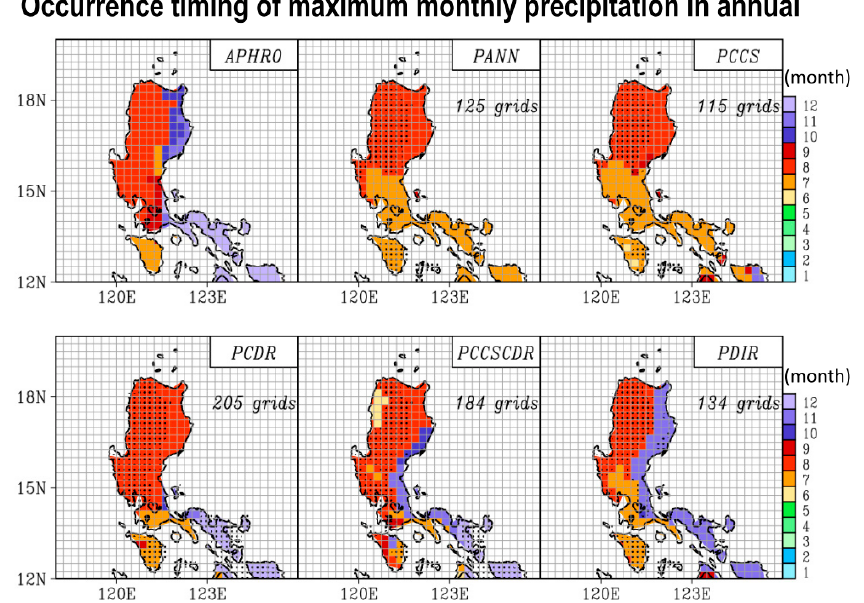
Figure 3. Phase diagram for depicting the timing of the occurrence of maximum value of monthly precipitation constructed based on APHRO and the five products of the PERSIANN-series (including PANN, PCCS, PCDR, PCCSCDR, and PDIR) that were averaged from 2003–2015. The gray line represents the spatial resolution of 0.25° × 0.25° in all data. In the five products of the PERSIANN-series, the areas that depict the same phase as that of APHRO are marked by black dots. To help the discussion in the main text, the number of grid points (at a 0.25° × 0.25° spatial scale) that are covered by dotted areas is provided in the top right panel of each SPP.